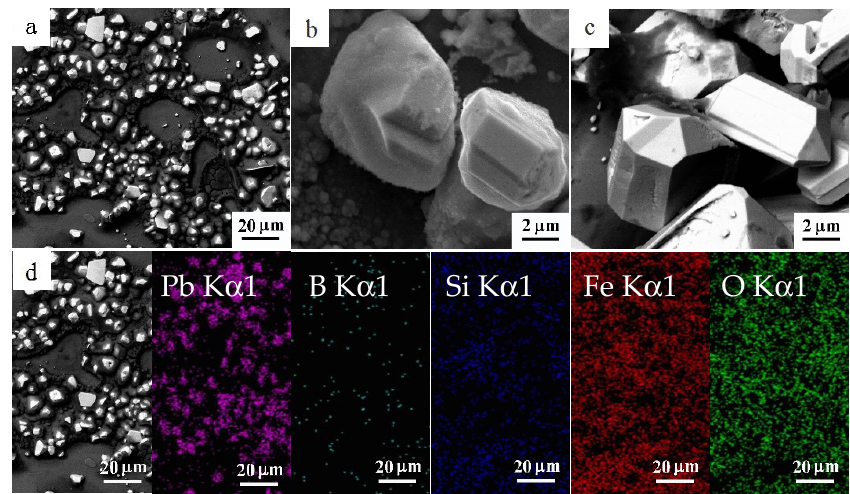
Figure 8. ( a ) SEM images of the precipitate after FeSiB AR reacted with the Pb(II) solution. ( b ) Enlarged secondary electron image and ( c ) backscattered electron image of the particles in ( a ). ( d ) EDS elemental mapping images of the precipitate.